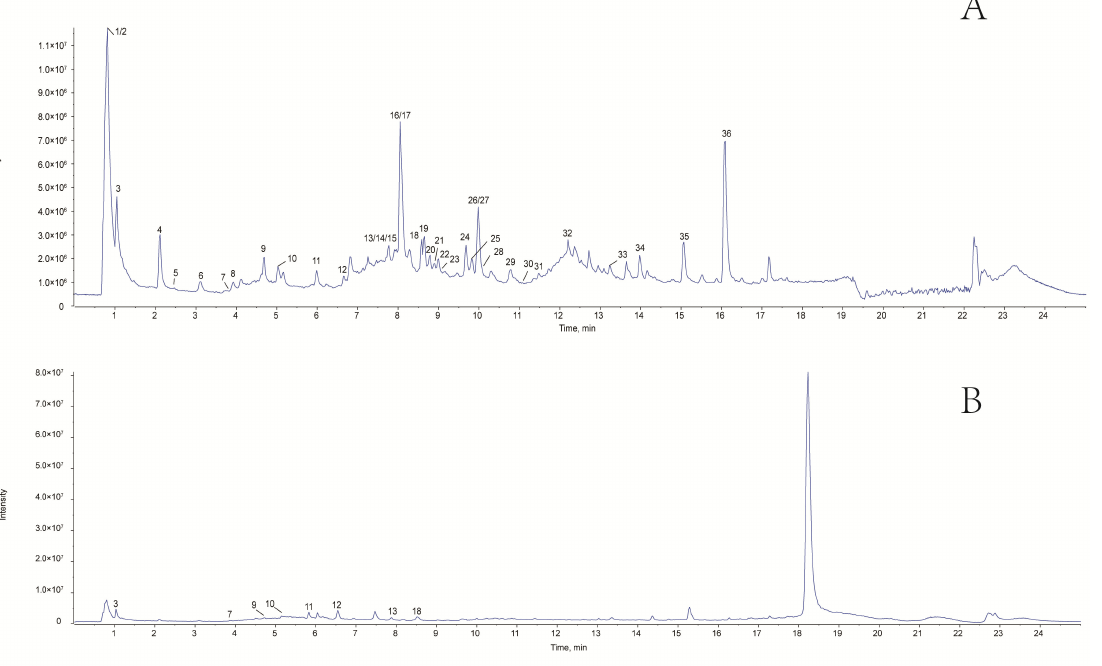
Figure 1. Representative total ion chromatograms of the WLJHT. ( A ) TIC of WLJHT sample in negative ion mode. ( B ) TIC of WLJHT sample in positive ion